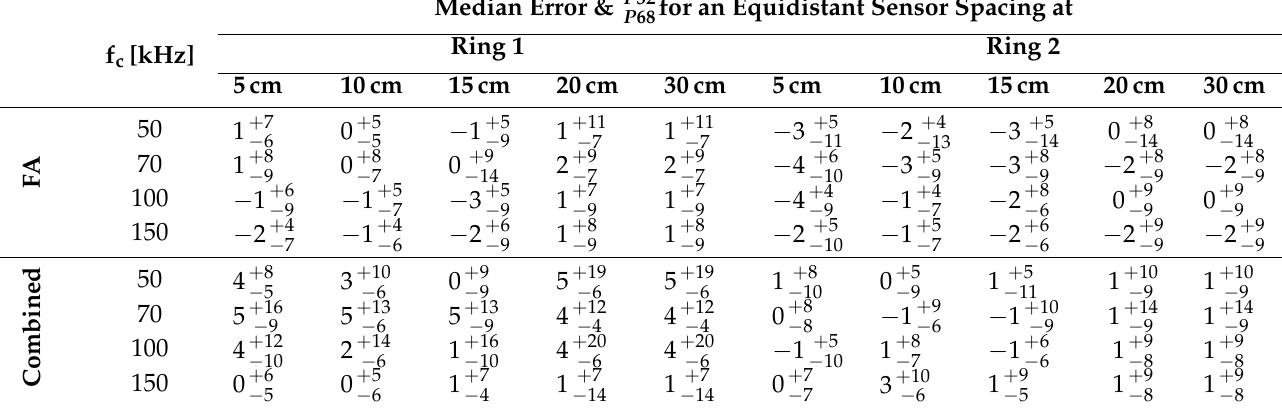
Table A4. Accuracy of the measured oil thickness